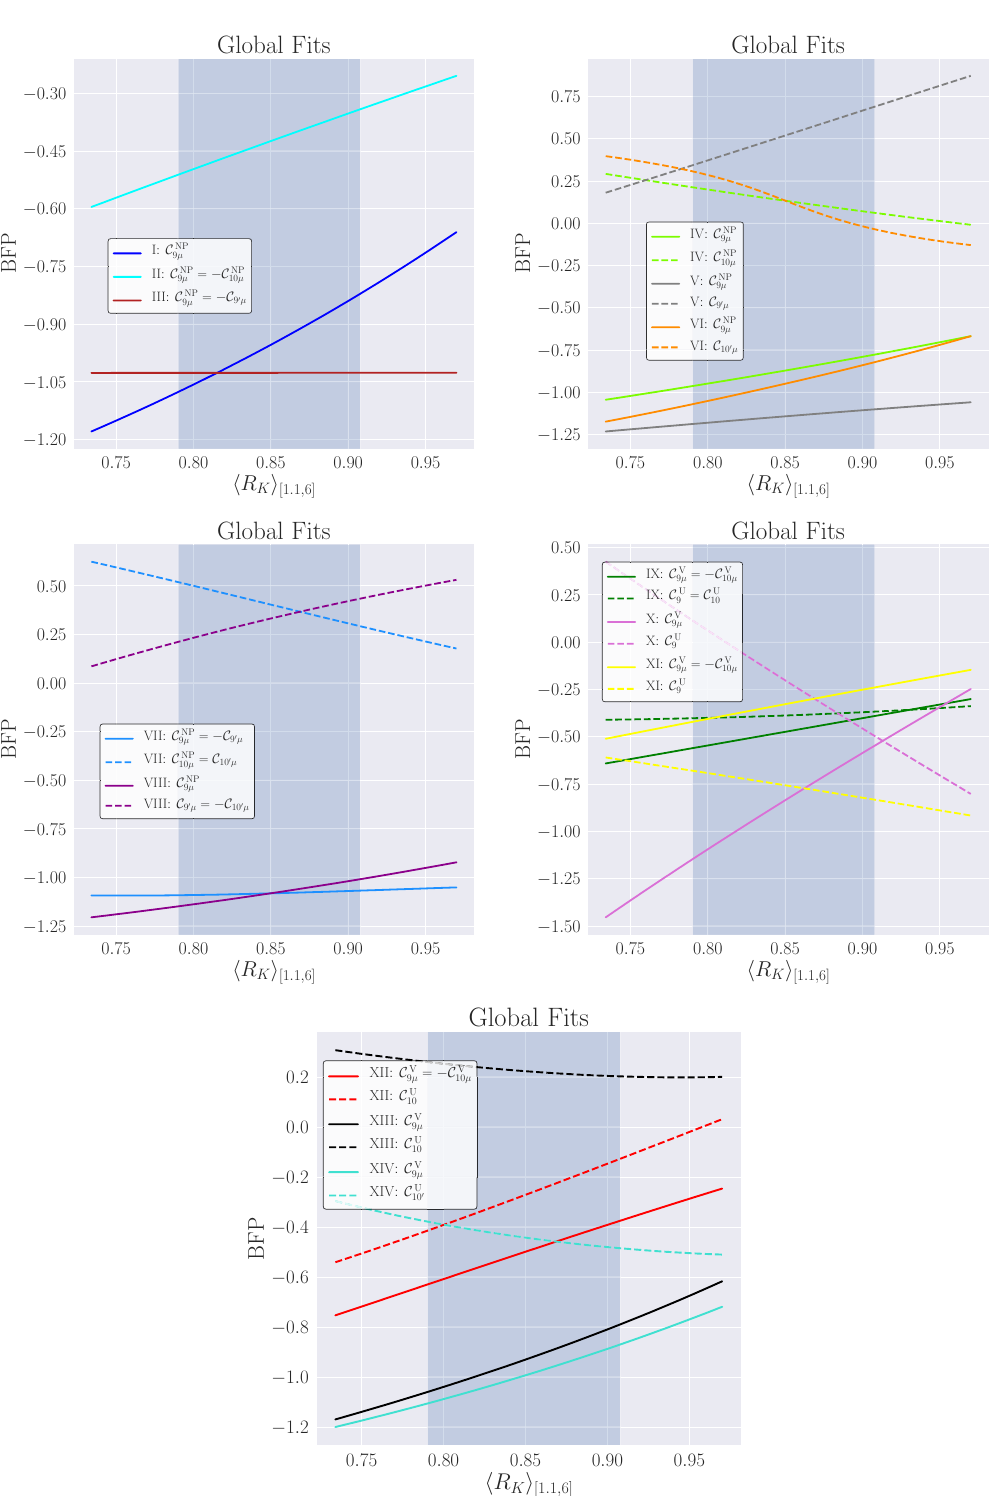
Figure 13. Global fit: impact of the central value of under